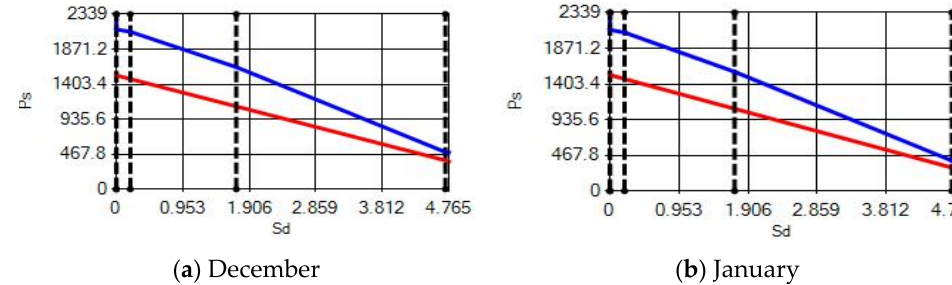
Figure 23. Condensation and evaporation amount chart for the building elements of the pumice external wall for the 2nd zone for ( a ) December and ( b ) January.